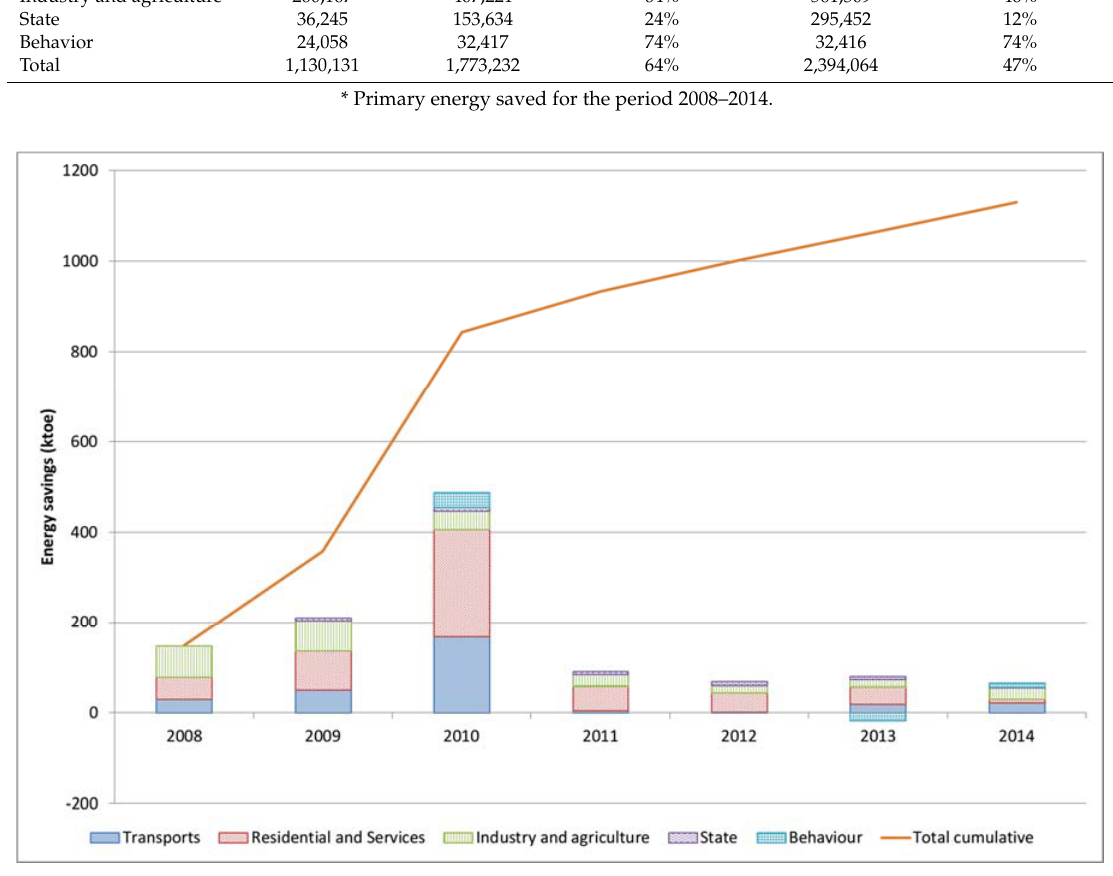
Figure 1. Impacts of the measures implemented in the different areas as well as the cumulative impact value